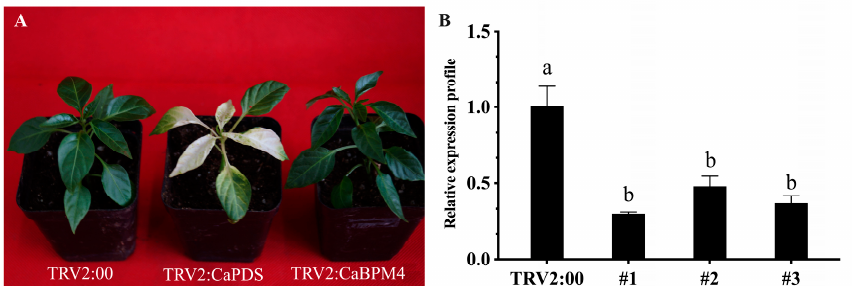
Figure 6. Effect of CaBPM4 -silencing in pepper plant. ( A ) Phenotypes of CaBPM4 -silenced, TRV2:00 (negative control) and TRV2: CaPDS (positive control, in which the endogenous phytoene desaturase (PDS) gene was silenced to cause photobleaching), and images were obtained after 35-days inoculation. ( B ) Real-Time RT-PCR analysis of CaBPM4 expression levels in TRV2:00 and CaBPM4 -silenced line (#1, #2, and #3 indicate three biological levels of efficiency of CaBPM4 gene silencing) 35 days after inoculation. Relative expression levels of the CaBPM4 were determined in comparison with that in TRV2:00. Small letters (a, b) represent significant differences ( p < 0.05).